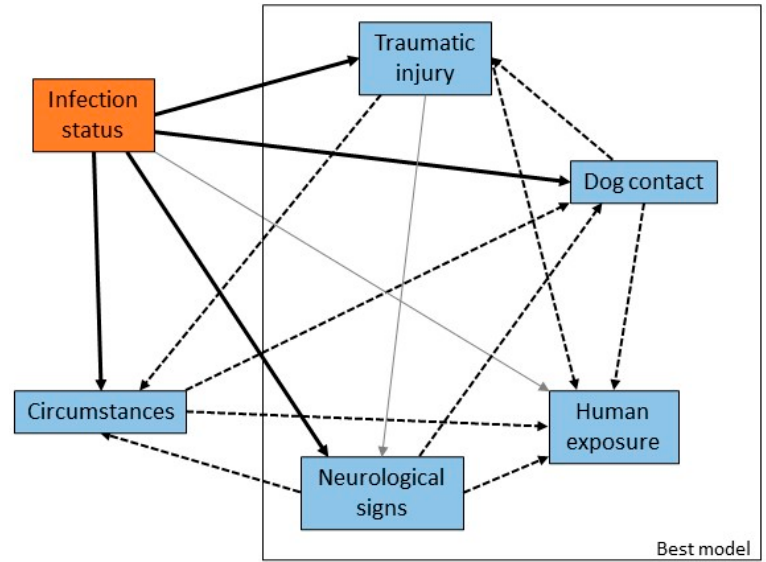
Figure 4. Causal web of association between presentation or clinical signs and ABLV infection status. Heavy black arrows are significant univariable associations between the presentation or clinical sign and infection status, dotted arrows are significant associations between pairs of variables, and grey arrows are plausible causal associations that were not statistically significant in our dataset. The rectangle encloses the suite of variables that produced the best multivariable model.